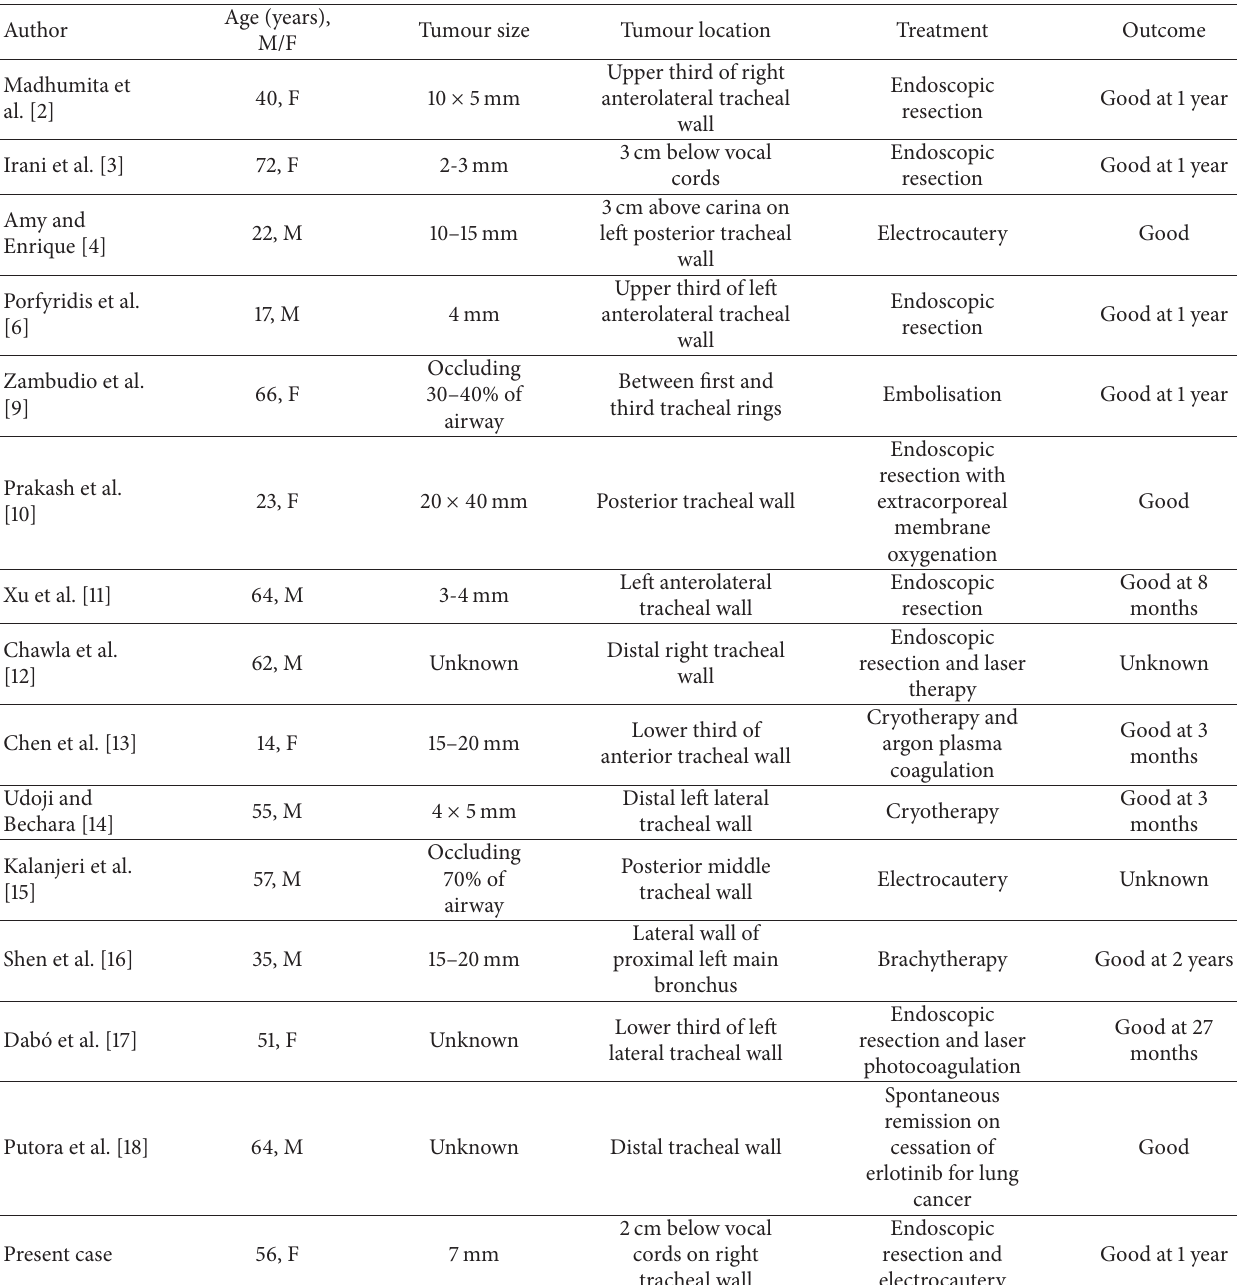
Table 1: Summary of previously reported cases of tracheal lobular capillary